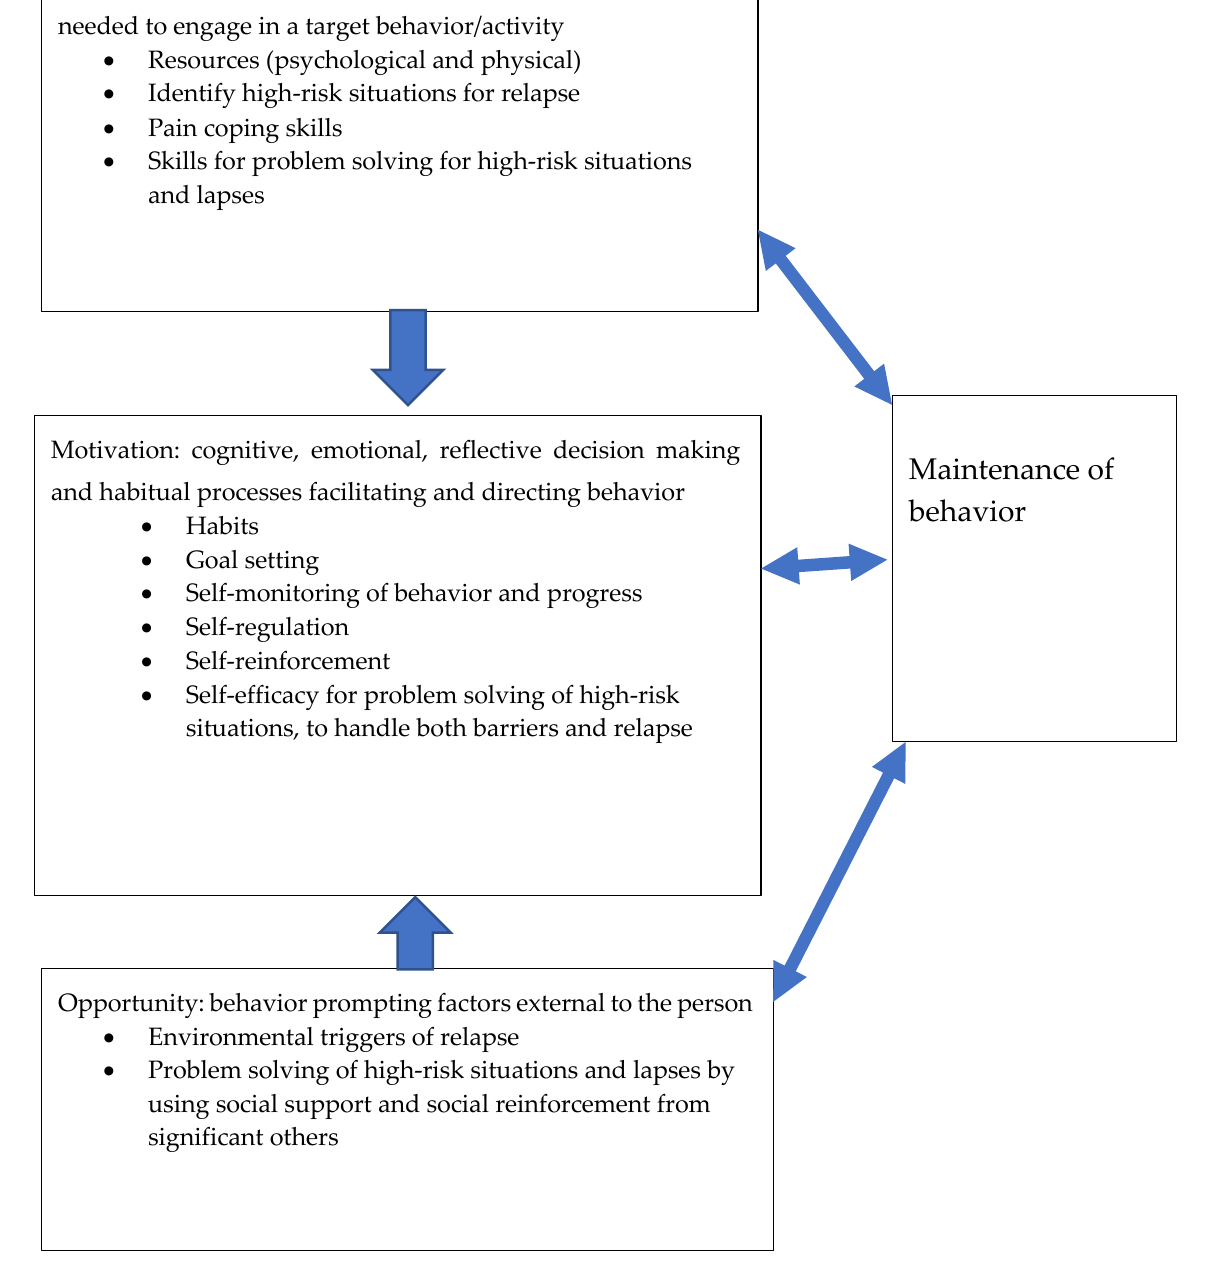
Figure 4. Model for the maintenance of a behaviour, inspired by [42]. The components were retrieved from previous studies on theoretical explanations of the maintenance of behavioural